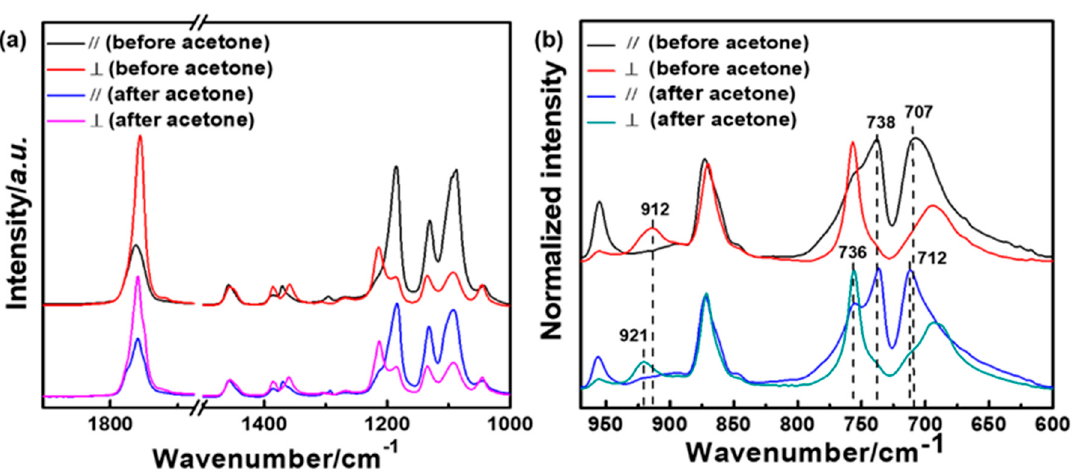
Figure 10. Polarized FTIR spectra of oriented PLLA film friction transferred at 100 °C before and after acetone treatment for 24 h in the wavenumber region of 1800-1000 cm − 1 ( a ) and 1000-600 cm − 1 ( b ), respectively.